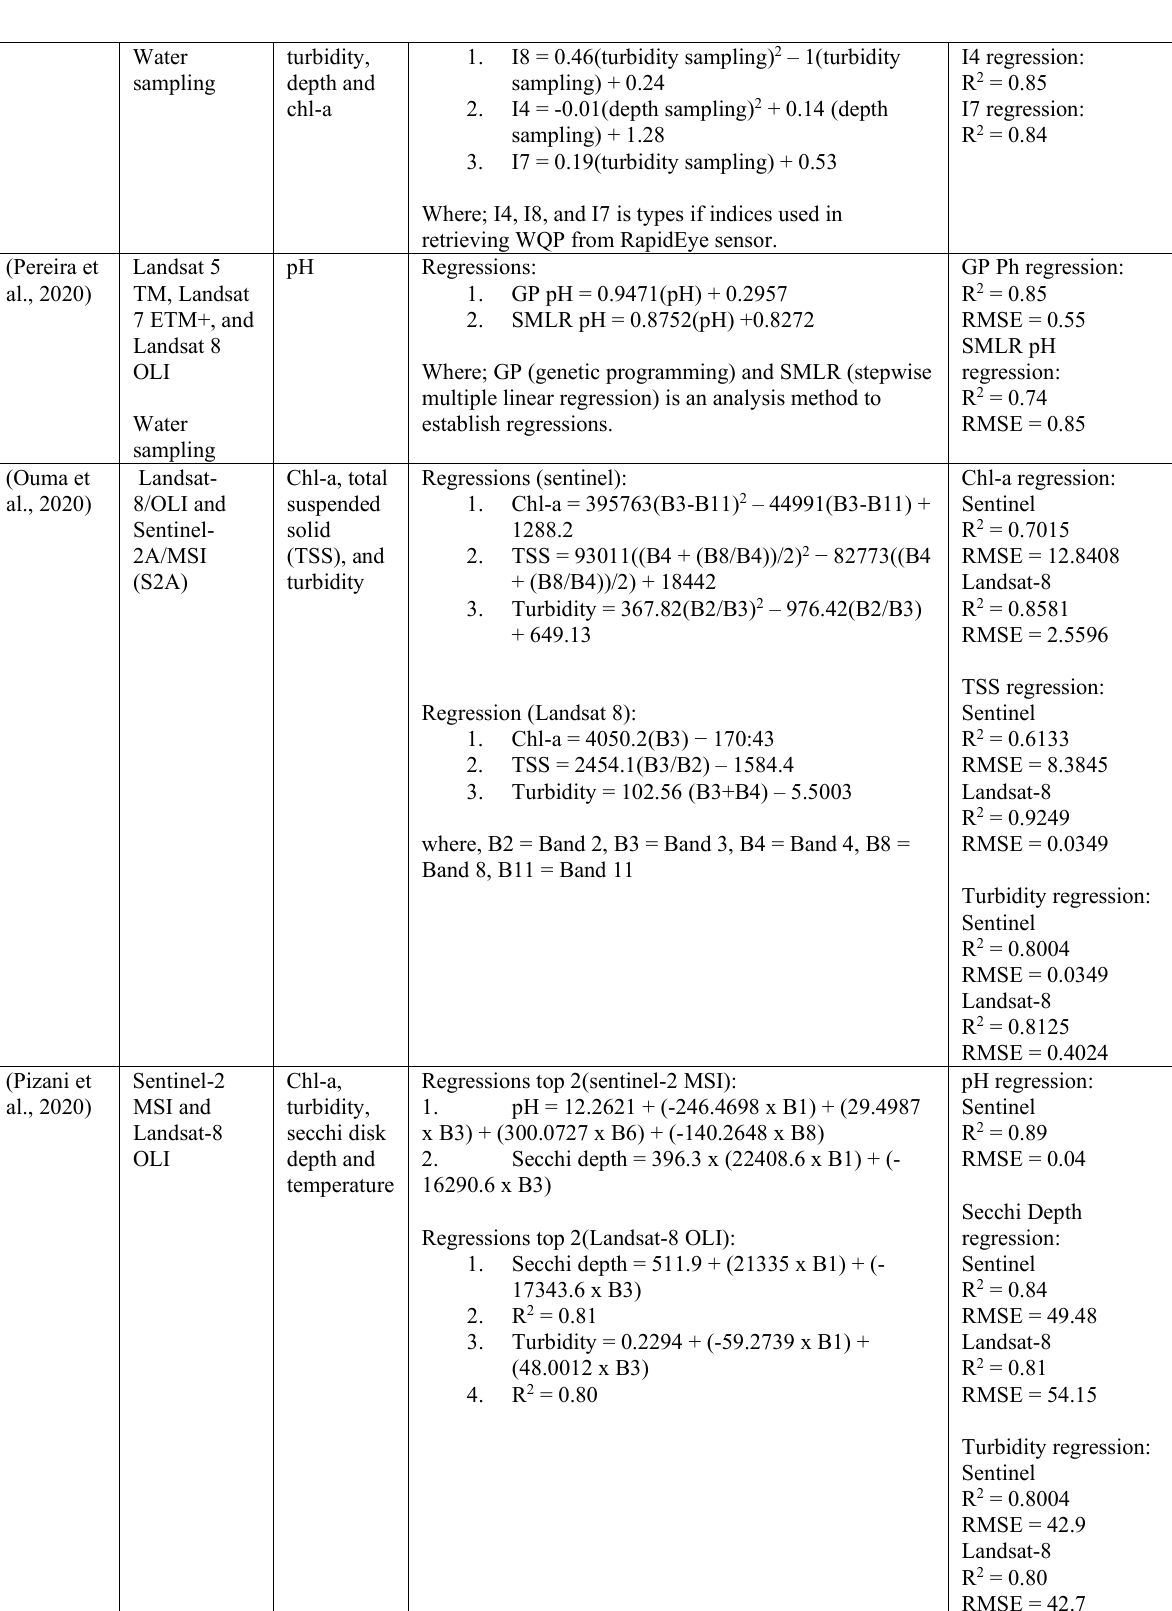
Table 4. Method and Regressions to acquired WQP from multiple Satellite Imageries